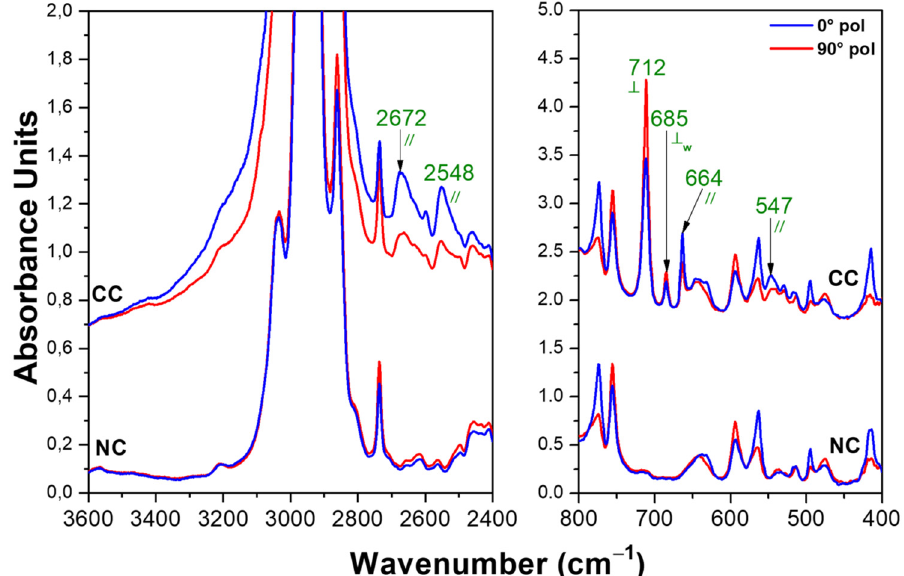
Figure 6. Polarized FTIR spectra measured with the polarization plane parallel (blue lines) and perpendicular (red lines) to the film stretching direction for two spectral ranges (3600–2400 and 800–400 cm − 1 ) for an axially oriented PPO film exhibiting the α NC phase, before and after BA sorption, leading to the corresponding CC phase. explanation of labels // and ⊥ can be found in Figure 3. The green labels indicate the peaks.